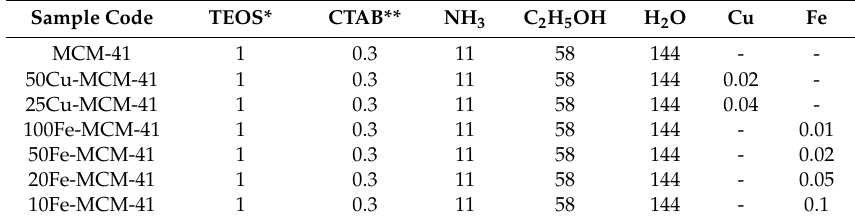
Table 2. The molar ratio composition of the synthesis mixtures used for the preparation of the transition metal containing MCM-41